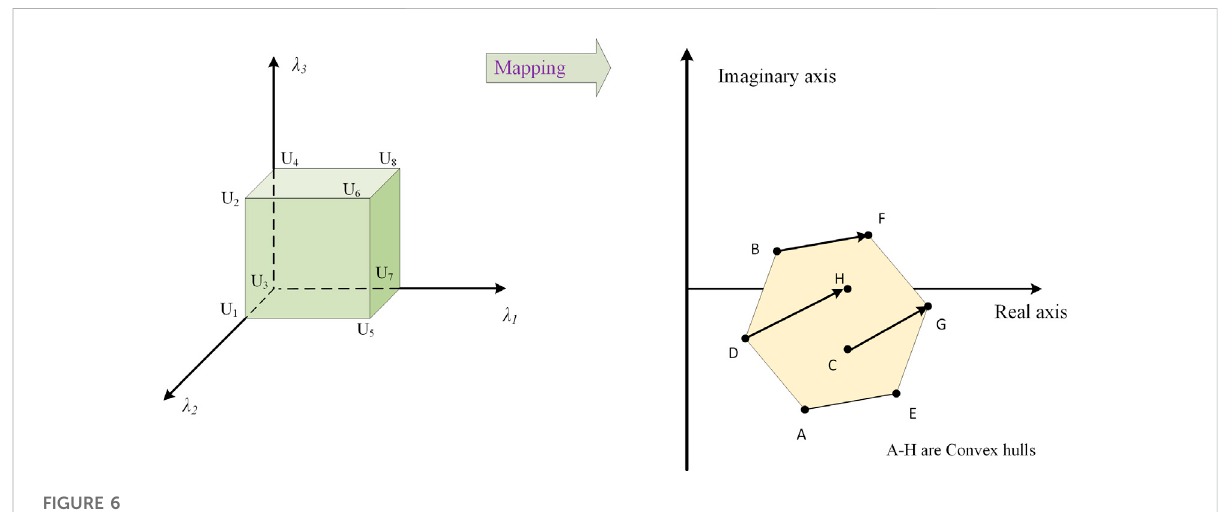
FIGURE 6 Structure of the mapping